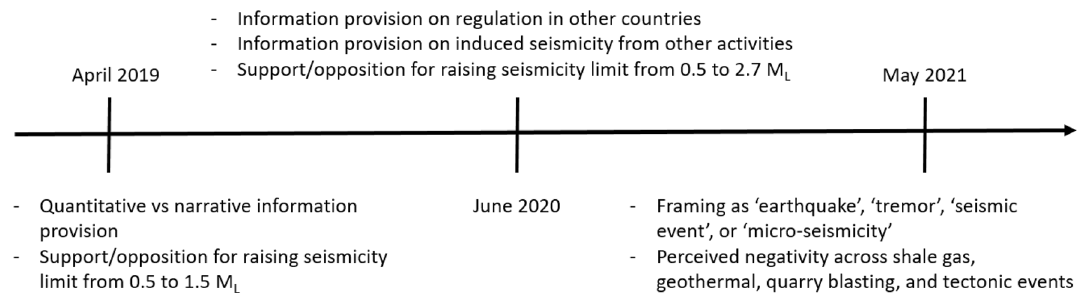
Figure 1. Three waves of surveys on perceptions of induced